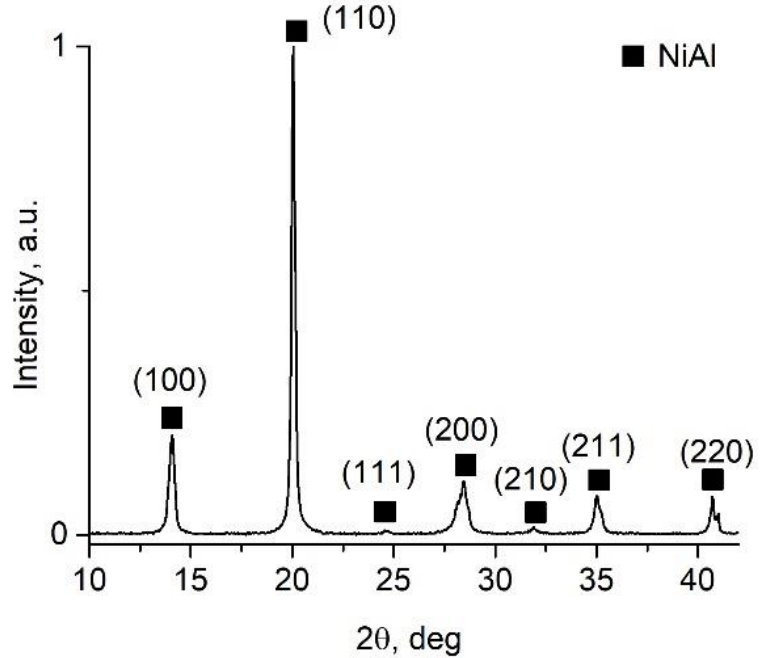
Figure 4. XRD pattern of NiAl-based coating obtained by non-vacuum electron beam cladding. Table 3. EDX results of the areas marked in Figure 3a.